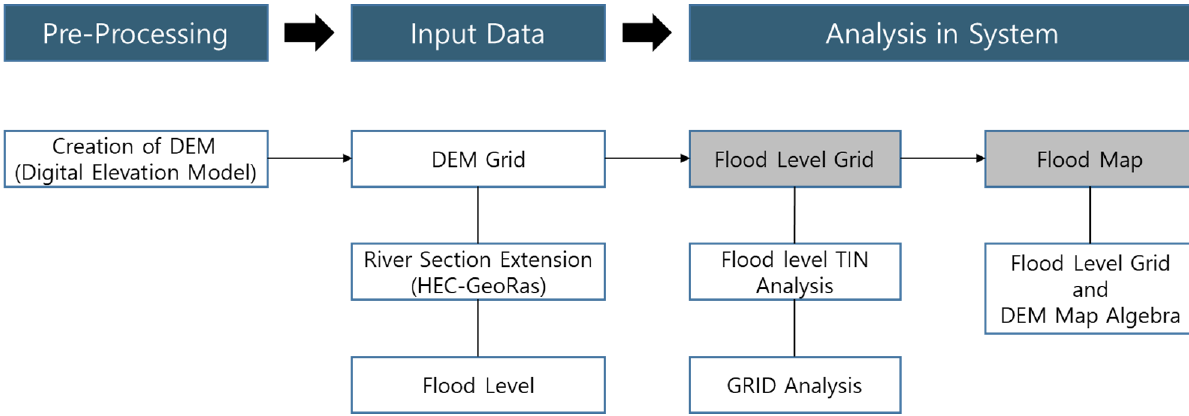
Figure 4. Procedure for flood inundation map construction.